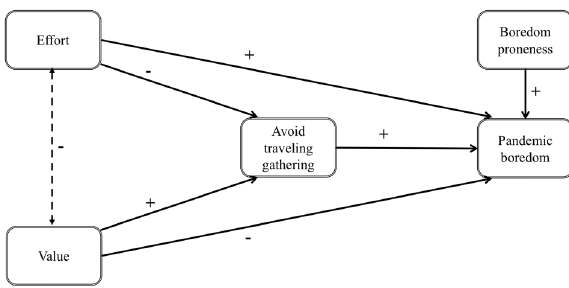
Fig. 1 Conceptual model in which the effect of effort and value on pandemic boredom is mediated by avoiding to travel and to